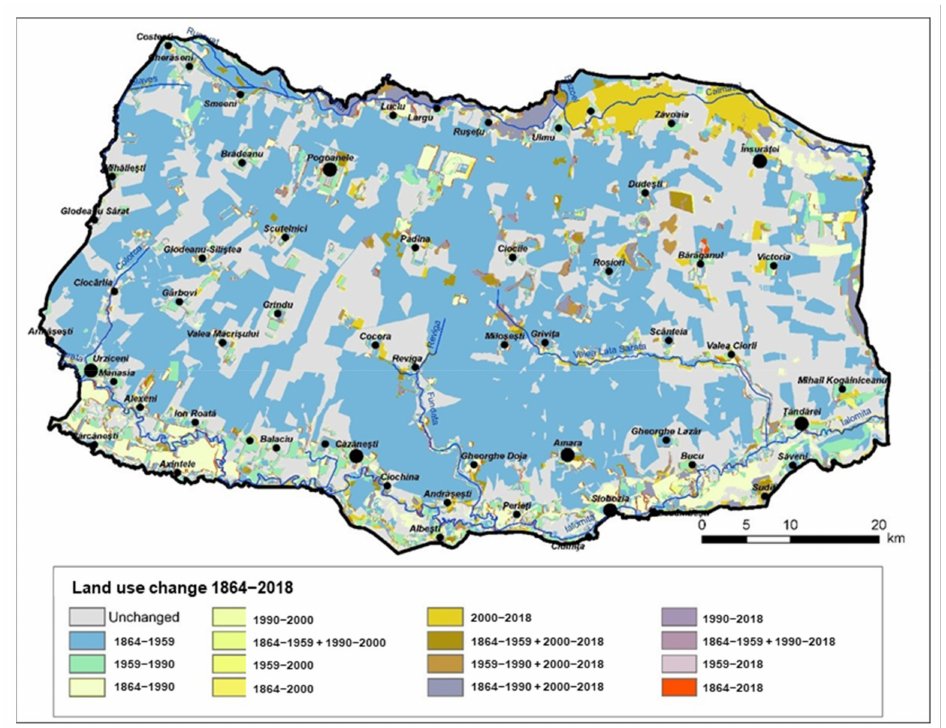
Figure 8. Surfaces affected by successive land use changes during the analysis period 1864–2018.